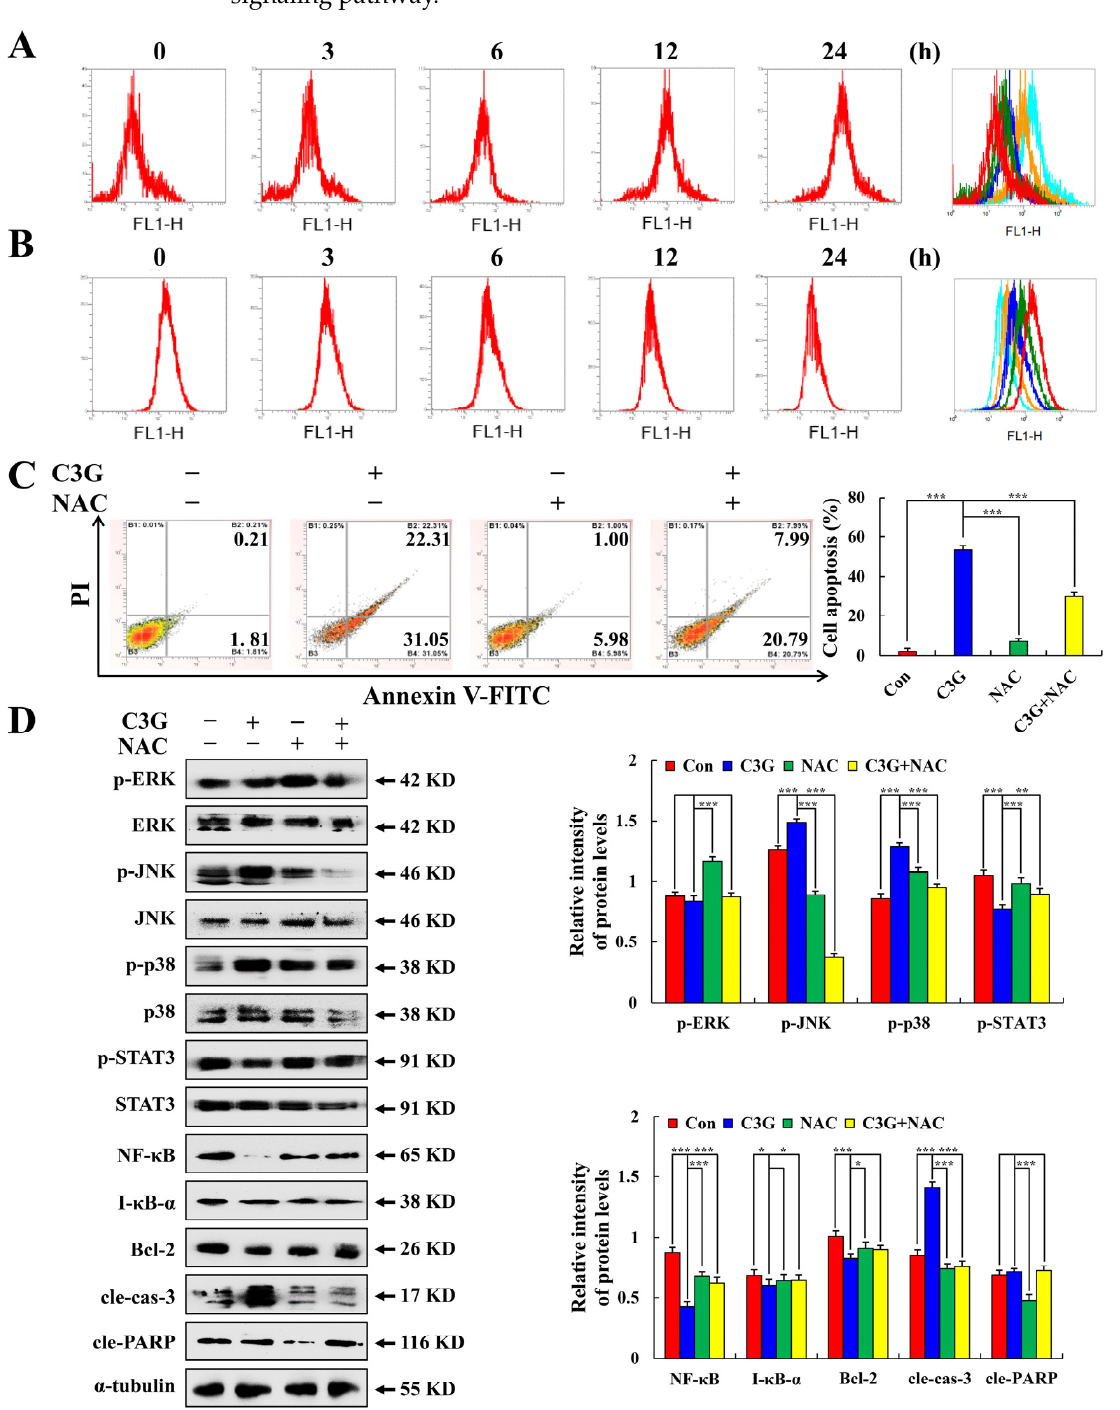
Figure 5. Effects of C3G on the ROS accumulation in MKN-45 cells. ( A ) ROS levels in MKN-45 cells after C3G treatment. ( B ) ROS levels in GES-1 cells after C3G treatment. ( C ) The percentage of apoptotic MKN-45 cells pretreated with NAC was detected using flow cytometry. ( D ) Western blot was used to detect the expression of apoptosis-related proteins in MKN-45 cells pretreated with NAC. α -tubulin served as an internal reference (* p ≤ 0.05, ** p ≤ 0.01, *** p ≤ 0.001 vs. 0 h or the NAC + C3G group).